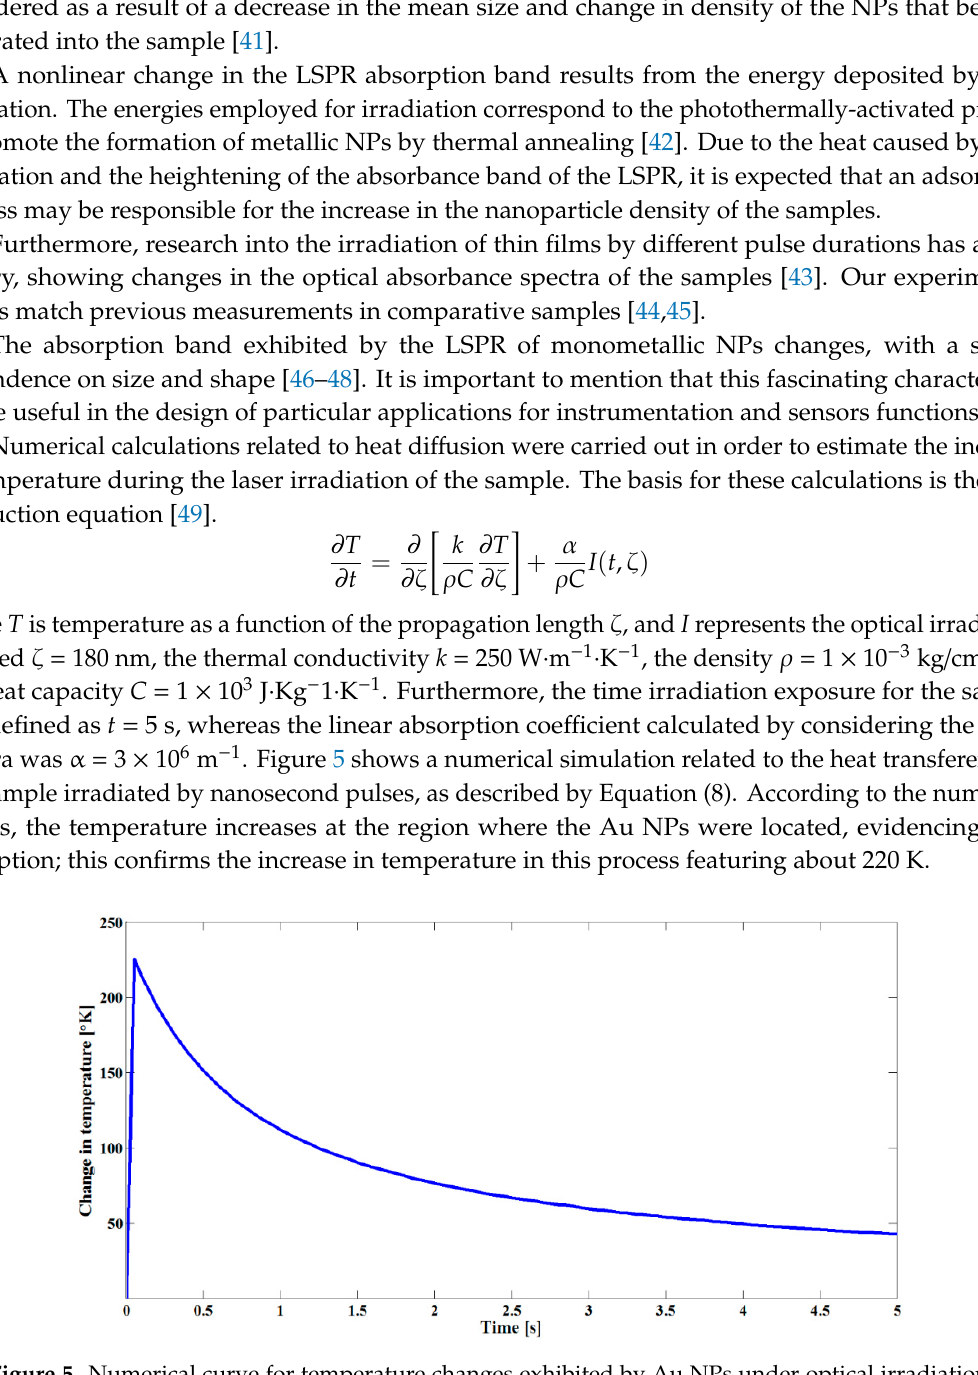
Figure 5. Numerical curve for temperature changes exhibited by Au NPs under optical irradiation vs. time.